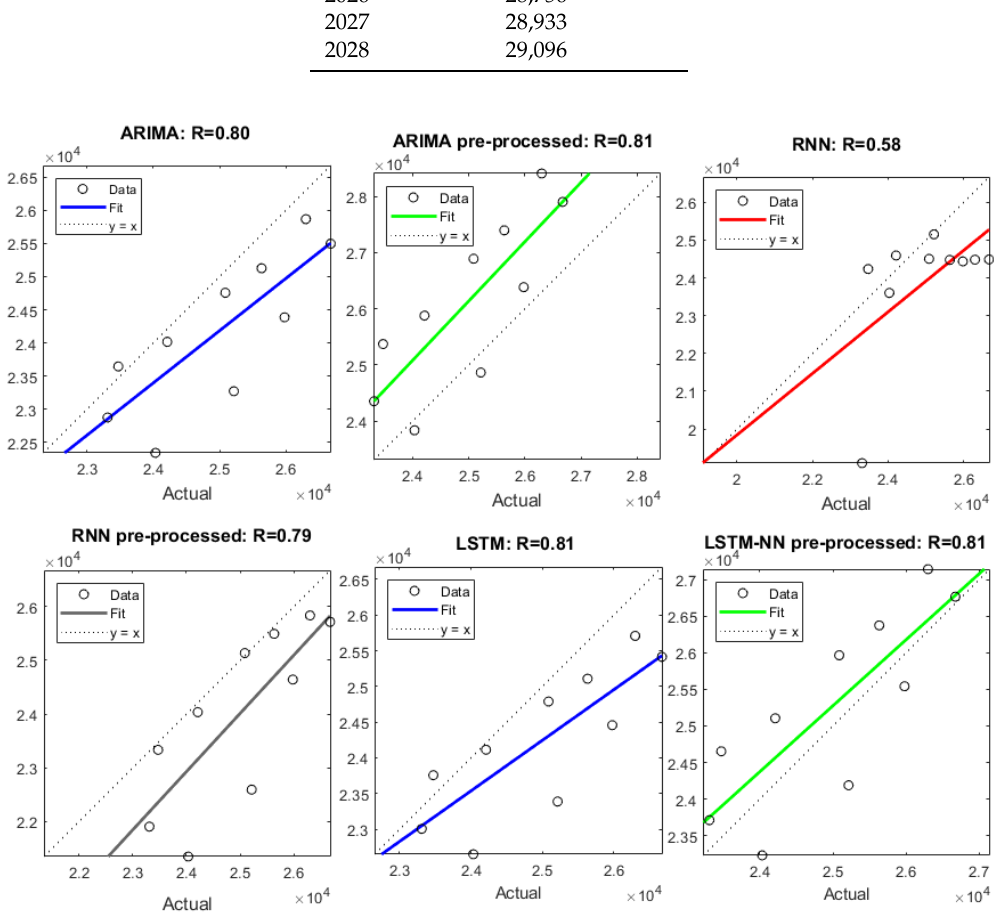
Figure 7. Regression plot of the forecasting models along with the correlation